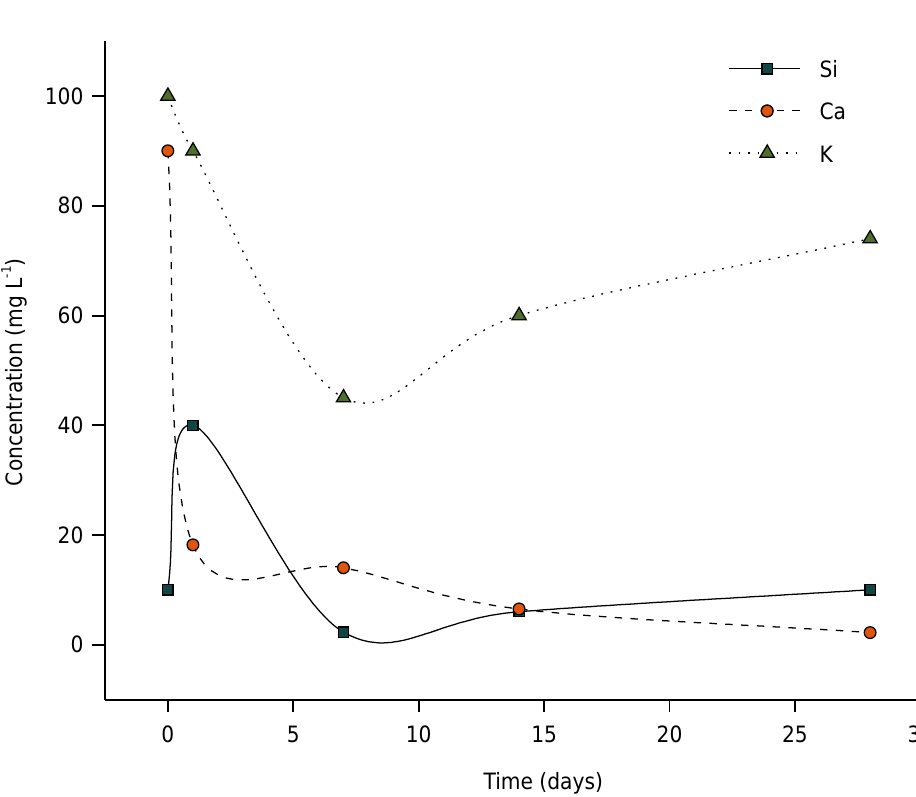
Figure 2. Silicon, K, and Ca concentrations in the alteration solution over time. The K concentrations were multiplied by 10 -2 in order to facilitate data